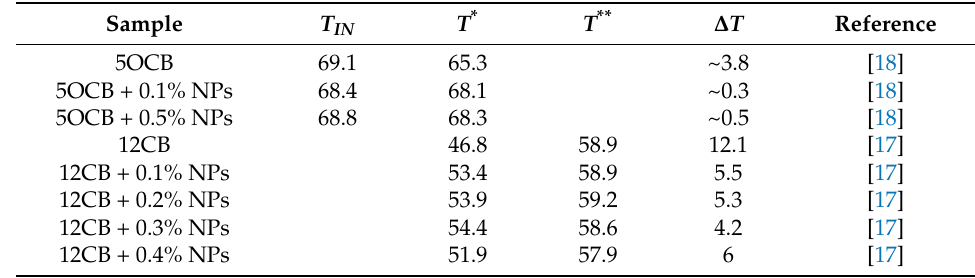
Table 1. Measured critical behavior for mixtures of different liquid crystals and nanoparticles. In References [17,18], they used BaTiO 3 nanoparticles.